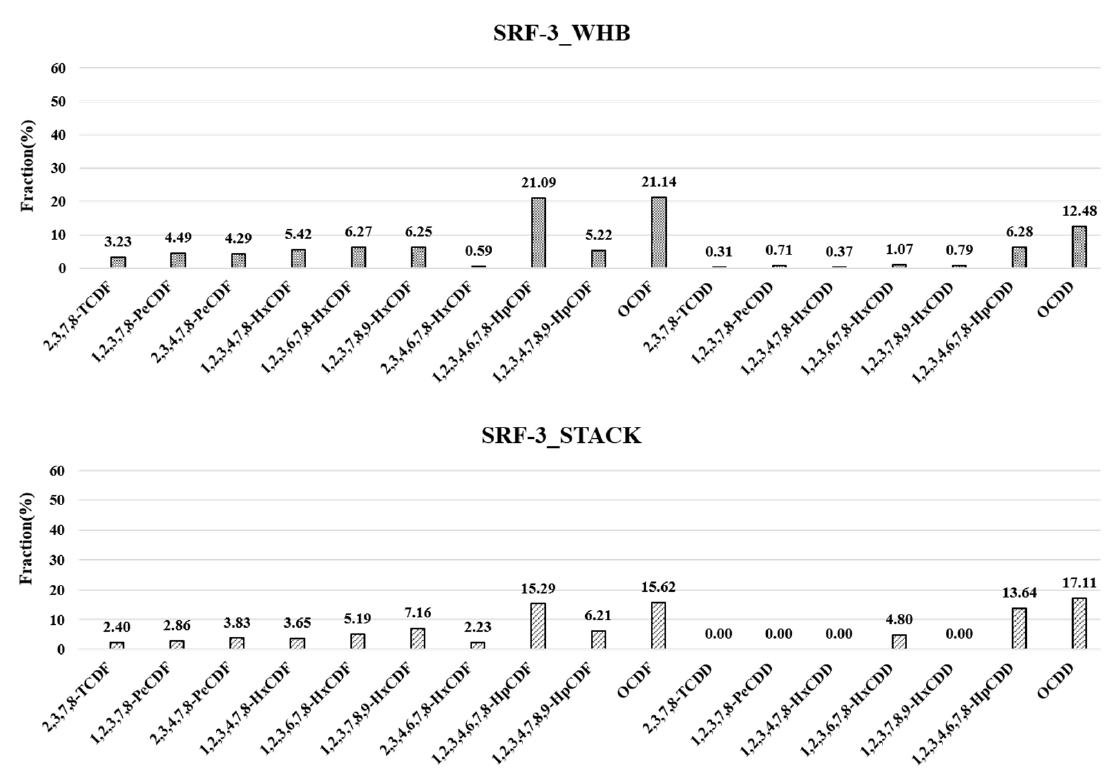
Figure 8. PCDD/DFs congener pattern in an SRF-3 incineration plant.